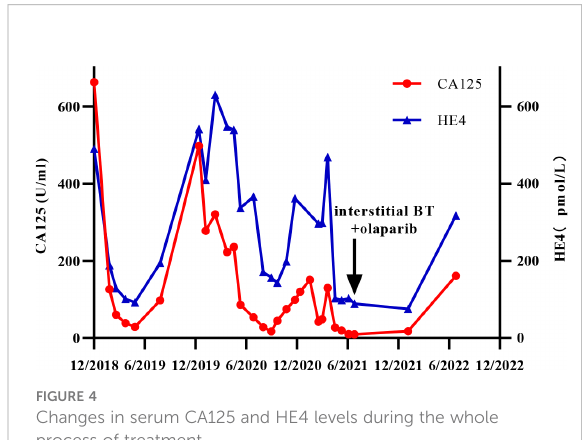
FIGURE 4 Changes in serum CA125 and HE4 levels during the whole process of